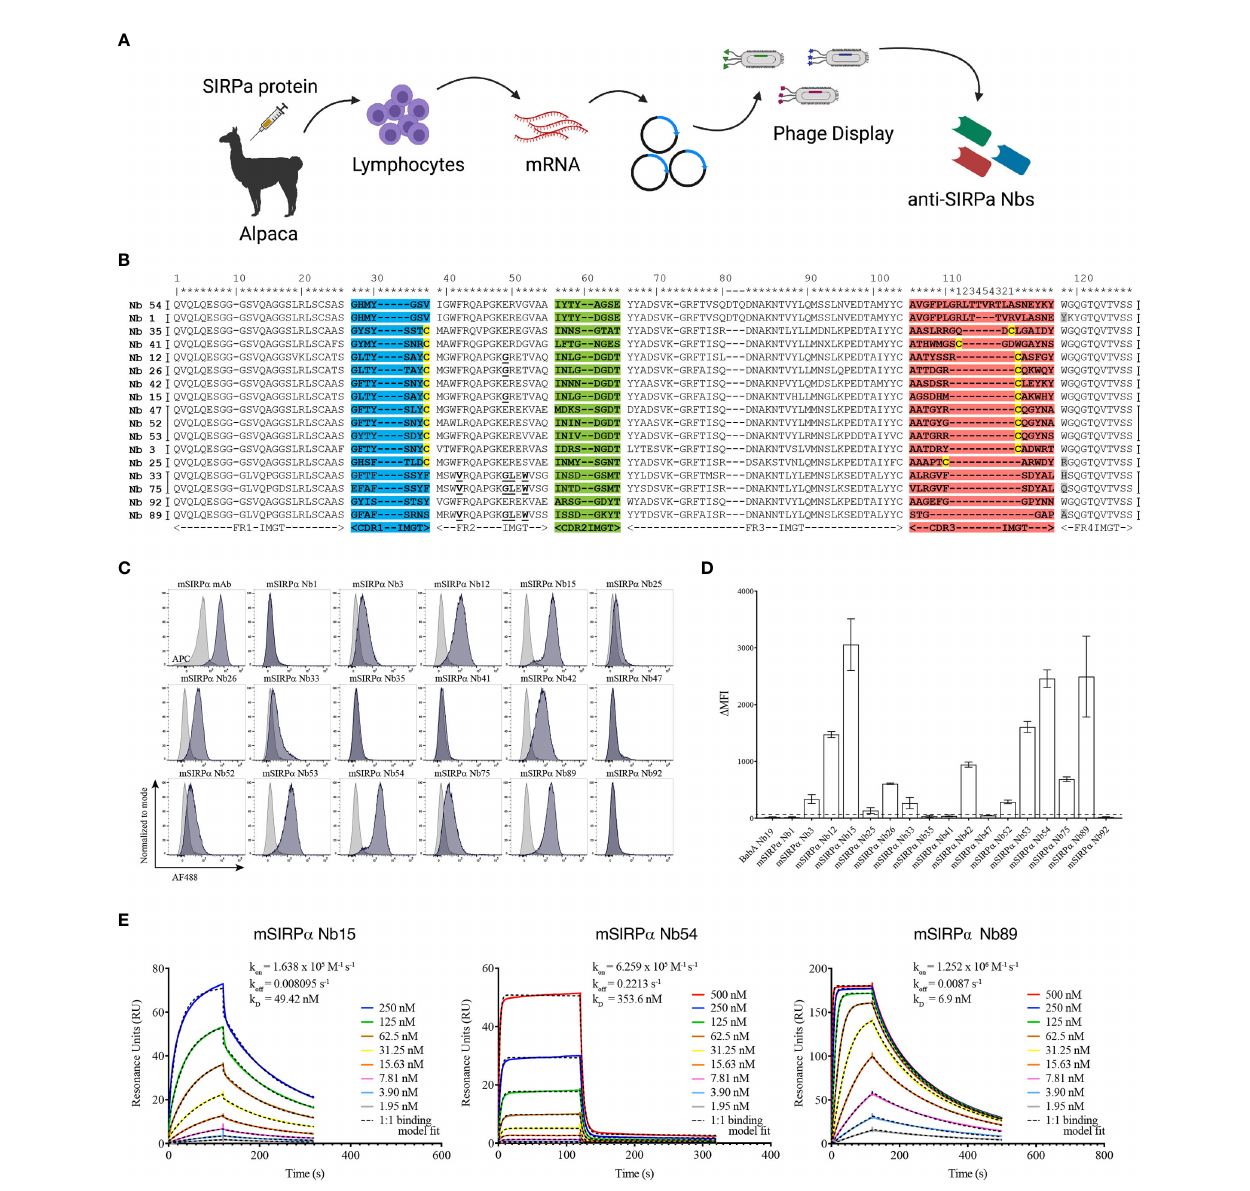
FIGURE 2 | Single-domain antibodies targeting SIRP a can be obtained following immunization with recombinant SIRP a protein. (A) Schematic representation of nanobody generation procedure. A camelid is immunized with recombinant SIRP a protein, the mRNA of peripheral blood lymphocytes is converted to cDNA and the region encoding the antigen binding domain of the camelid heavy chain-only antibodies is ampli fi ed by PCR and cloned in a phage display vector. Antigen-speci fi c nanobodies are retrieved after phage display and panning on plastic coated SIRP a . (B) Amino acid sequence of mSIRP a nanobodies, with numbering according to the International ImMunoGeneTics – IMGT – information system http://www.imgt.org (43). The CDR1, CDR2 and CDR3 regions are colored in blue, green and red, respectively. The cysteine residues used as subfamily-hallmarks are highlighted in yellow. The amino acids which differ from the typical VHH hallmark residues in framework-2 are in bold and underlined. The amino acid at position 118 (Trp) is highly conserved, however, in nanobodies this amino acid is sometimes substituted, usually with Arg and highlighted here in grey. Each nanobody family is based on the sequence identity of the CDR3 region and nanobodies belonging to the same family are grouped, indicated by the vertical black lines on either side of the sequence (14 families in total). Asterixes on top are used to indicate amino acid positions. (C) Representative histogram plots of mSIRP a nanobodies binding to RAW 264.7 macrophages. Overlay of binding signals of mSIRP a nanobodies (blue) versus a non-targeting nanobody BabA Nb19 (grey). Note: the fi rst plot shows binding of monoclonal antibody targeting mSIRP a (positive control, blue) and mouse IgG (isotype control, grey) (D) Median fl uorescence intensity (the difference between the signal of the nanobody and the signal of the mouse anti-HA IgG) of the mSIRP a nanobodies binding to RAW 264.7. The dashed black line is de fi ned by the triple D MFI value of the non-targeting nanobody (BabA Nb19) and it represents the threshold above which a nanobody is considered to bind speci fi cally to its target. (E) Kinetic rate constants determination by SPR: the sensorgrams of different concentrations (as indicated in the inserts) of mSIRP a nanobodies binding to the recombinant antigen. Kinetics were measured with two-fold serially diluted nanobodies and the fi tting of the binding curves was using a 1:1 binding mathematical